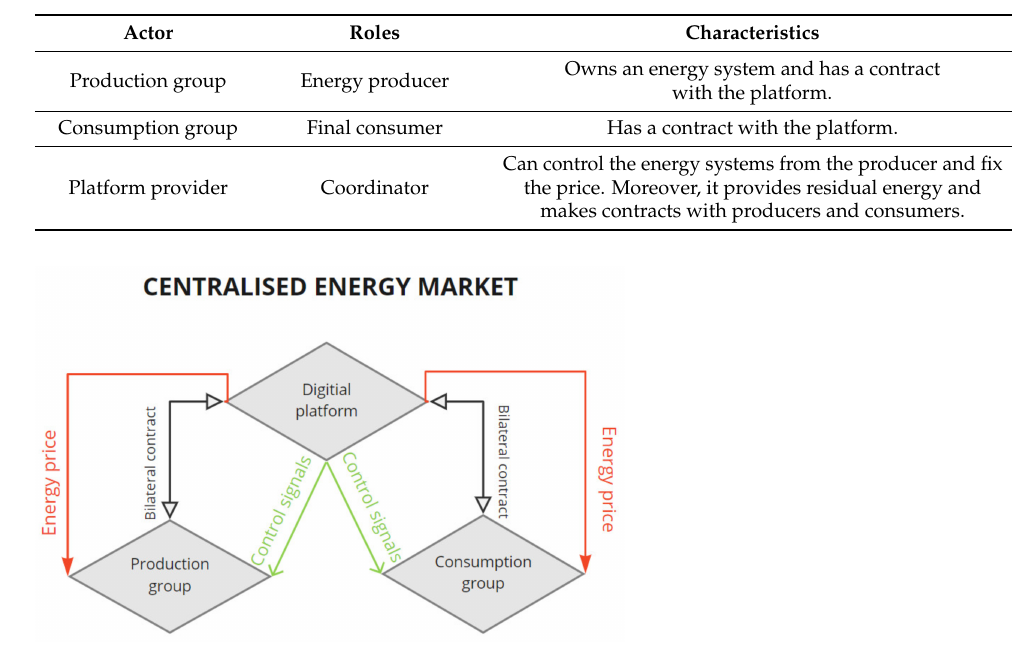
Table 9. Characteristics of the actors’ roles for the centralised P2P -ET market. Table based on own interpretation from Section 2.2.1.